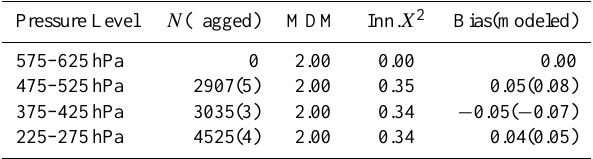
Table 2. Summary of the Asian CONTRAIL CO 2 observation data assimilated between 2006 and 2010. MDM (model–data mismatch) is a value assigned to a given site that is meant to quantify our ex- pected ability to simulate observations and used to calculate the in- novation X 2 (Inn. X 2 ) statistics. N denotes the number available in CTDAS. Flagged observations mean a model-minus-observation difference that exceeds 3 times the model–data mismatch, these data are therefore excluded from assimilation. The bias is the average of the posterior residuals (assimilated values–measured values), while the modeled bias is the average of prior residuals (modeled values– measured